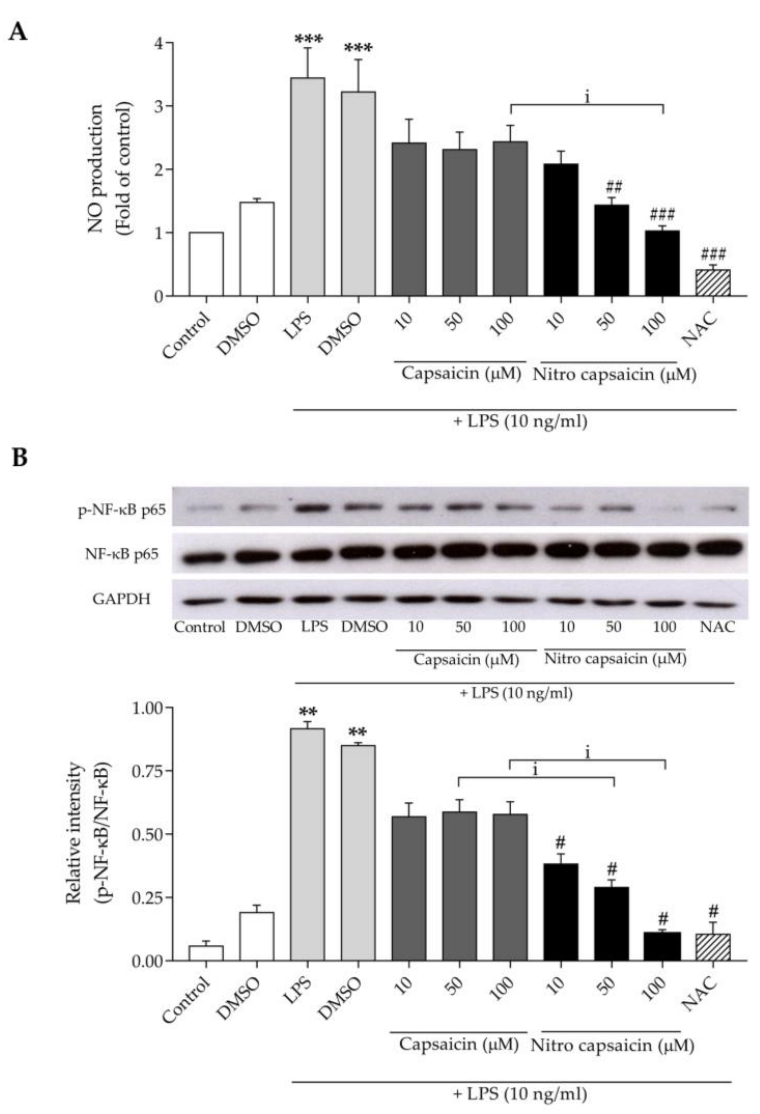
Figure 2. Effect of nitro capsaicin against LPS-induced NO production in SIMA9 cells. ( A ) Inhibition of LPS-induced NO production by nitro capsaicin; ( B ) Western blot analysis of p-NF- κ B p-65 Ser536 and NF- κ B p-65 expression. NAC (10 mM) was used as the positive control. ** p < 0.01 and *** p < 0.001 versus control group; # p < 0.05, ## p < 0.01, and ### p < 0.001 versus LPS-treated group; and i p < 0.05 versus capsaicin-treated group.